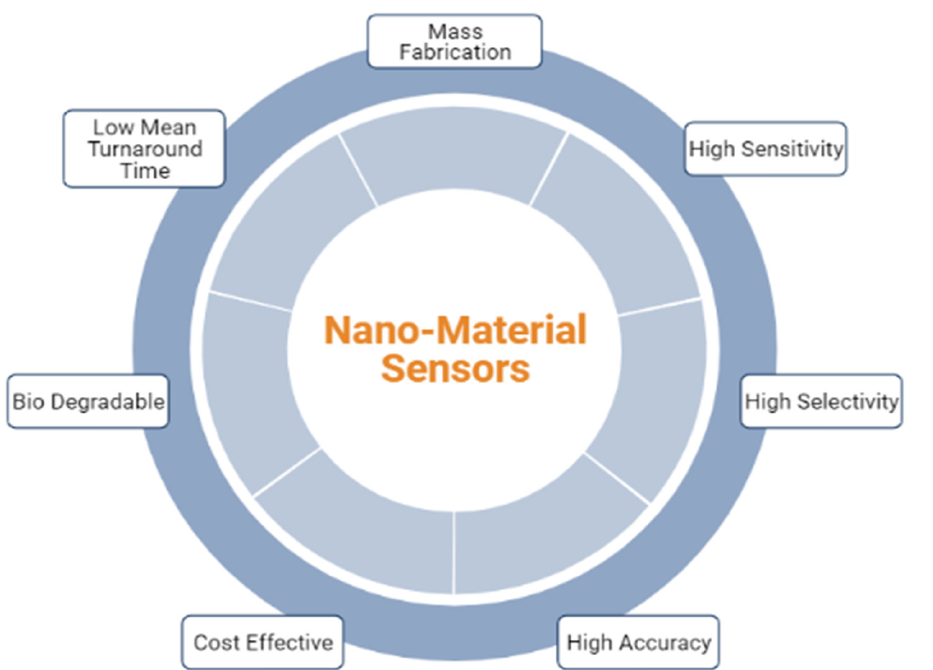
Figure 5. Salient features of nanomaterial ‐ based sensors.